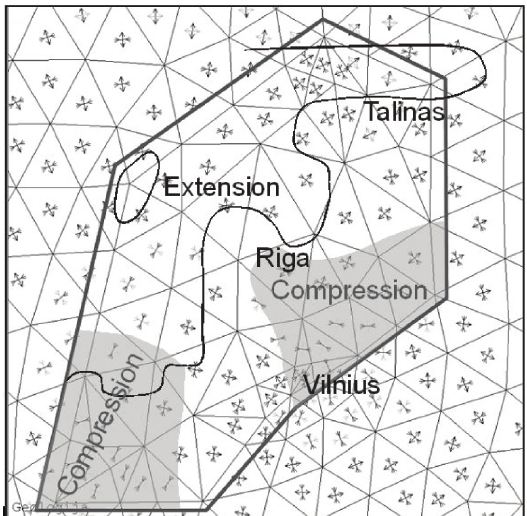
Fig. 5. The modelled stress field of the Baltic region defined from the GPS